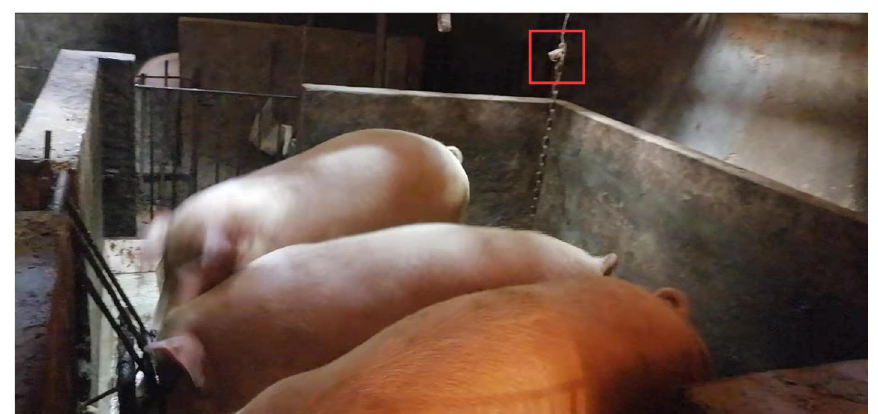
Fig 2. Experimental environment and equipment placement diagram.